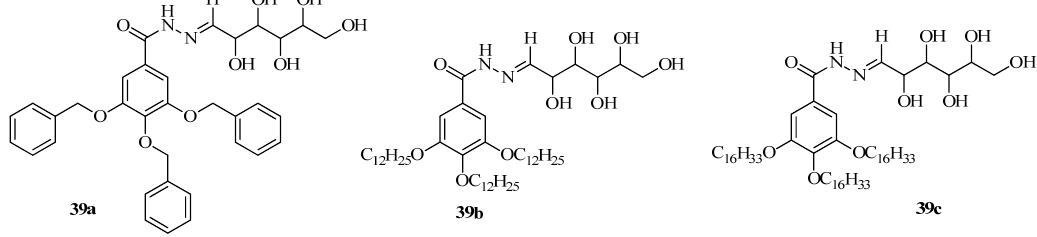
Figure 28. Glucose derived poly(arylether)dendritic molecules.